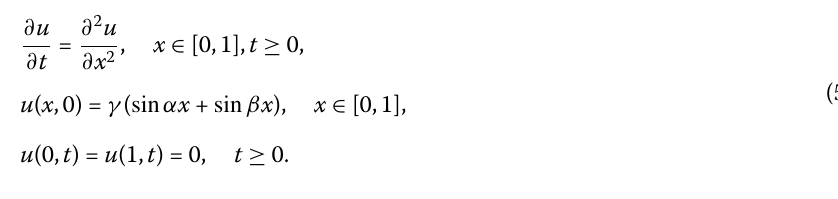
terms of the absolute errors, computing time and the order of convergence of the